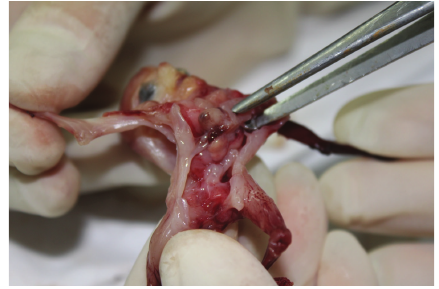
Figure 2: Appearance of the fetus at